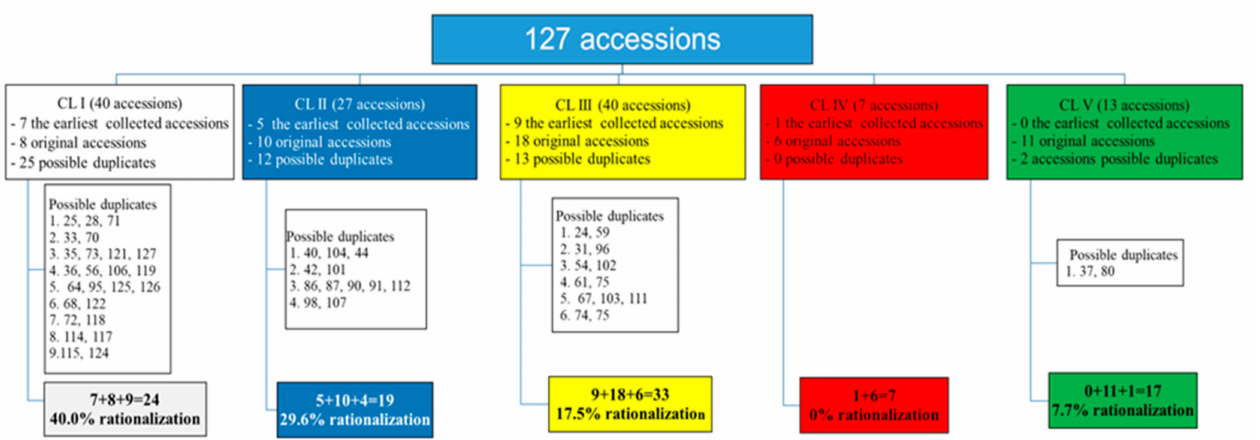
Figure 5. Possible duplicate accessions in the MRIZPGB yellow-orange Montenegrin maize gene pool. 2.3.2. The Allocation of MGB Yellow-Orange Maize Landraces into Defined